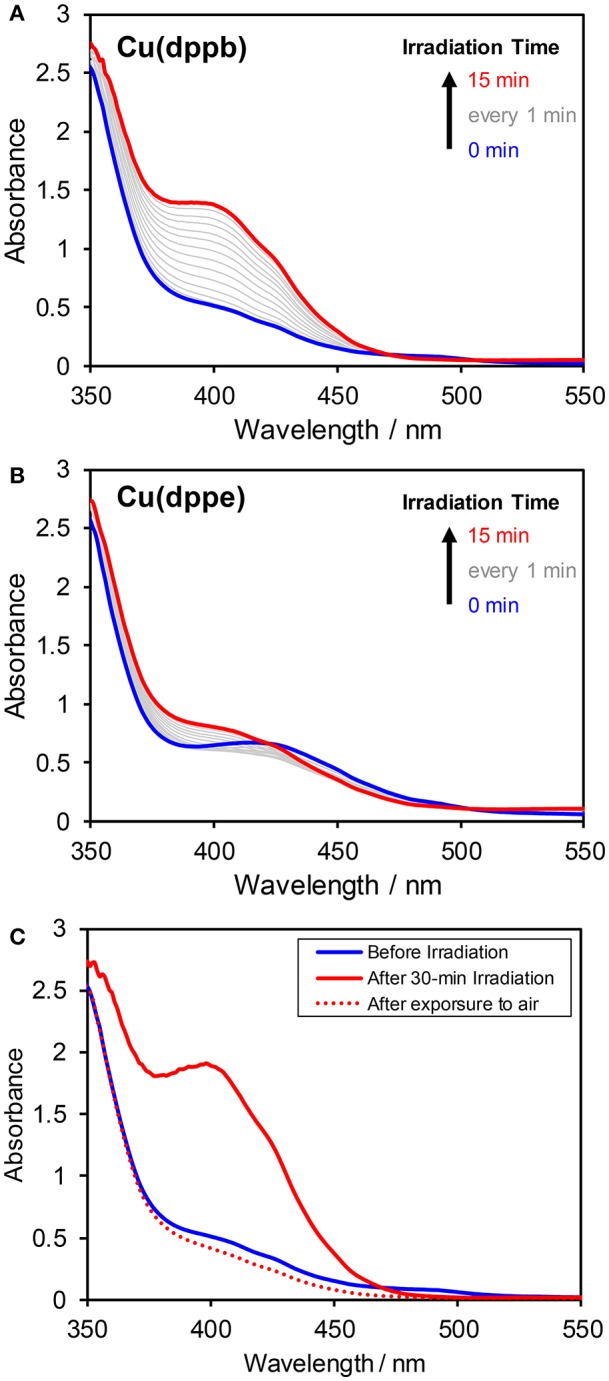
Absorption spectral changes of DMA–TEOA (4:1 v/v) solutions containing BIH (0.1 M) and 0.1 mM of (A) Cu(dppb) or (B) Cu(dppe) under an argon atmosphere. The solution was irradiated with 430-nm monochromic light. (C) Absorption spectral changes of the reaction solution of Cu(dppb) measured before irradiation (blue solid line), just after 30-min irradiation (red solid line), and after irradiation and subsequent exposure to an ambient air (red dotted line).